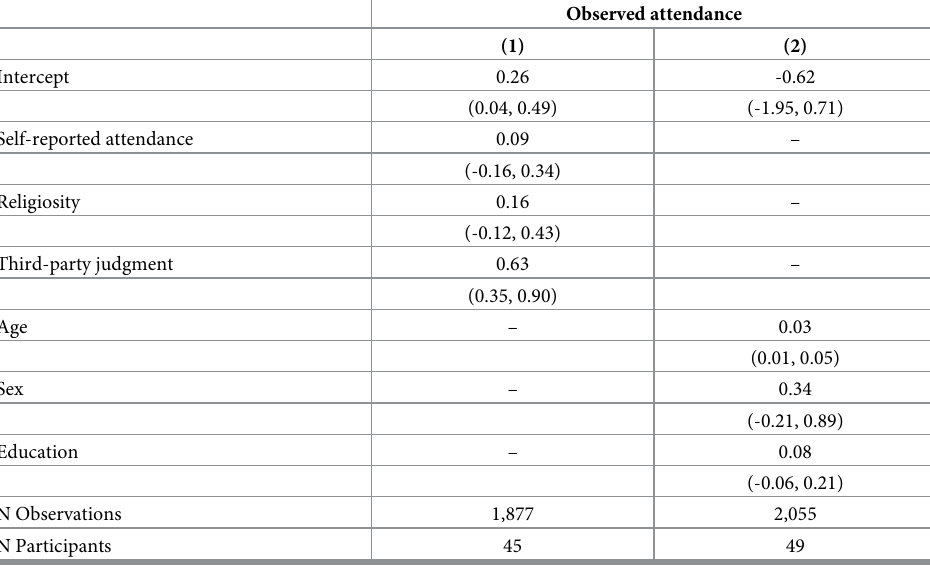
Table 1. Raw estimated with 95% CIs from GLMMs reporting the coefficients for self-reported, peer-reported, and demographic variables predicting observed attendance at church